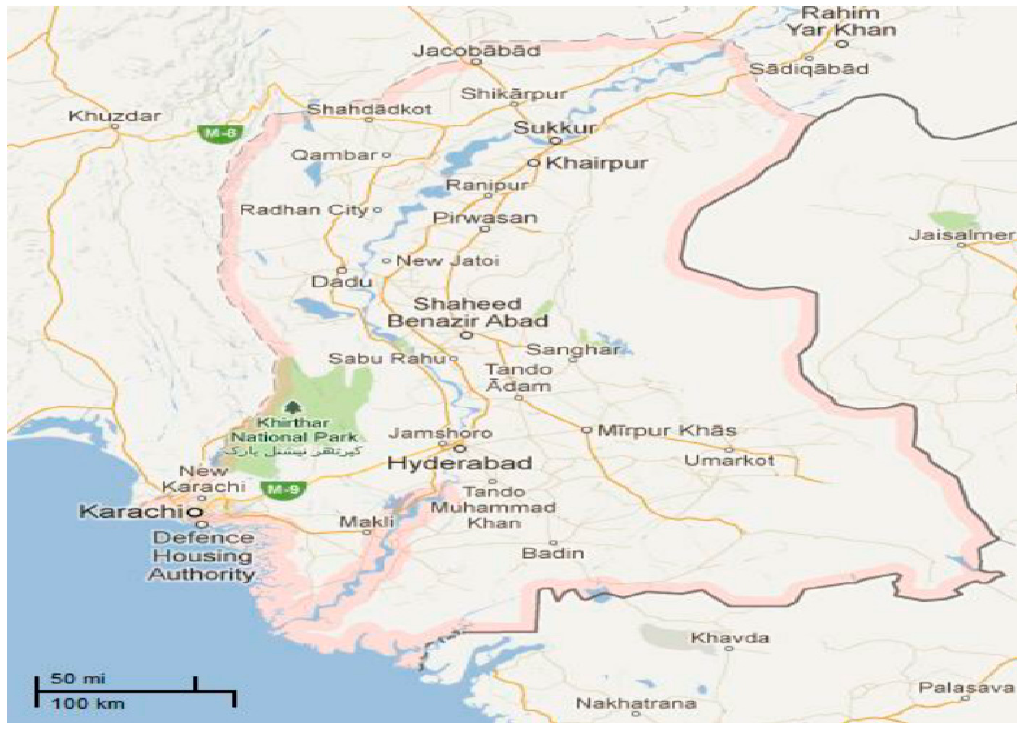
Figure 1. Sindh province map [28].